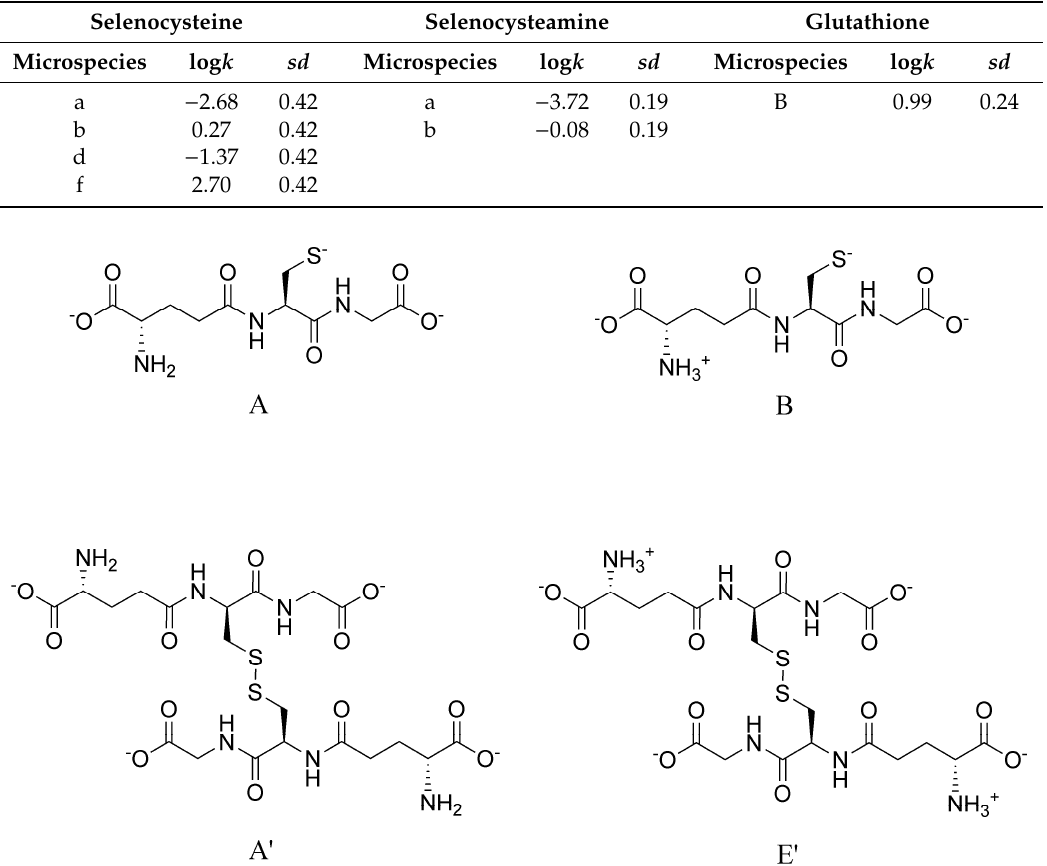
Table 3. Microspecies-specific, pH-independent equilibrium constants of selenocysteine, selenocysteamine and glutathione with dithiothreitol in logarithmic units, with standard deviations. The parameter of glutathione was determined for the B microspecies only, for further calculation (see Figure 6 for glutathione microspecies).